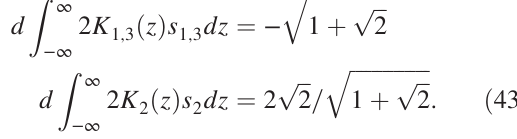
TABLE II. Entrance and exit conditions for the moments in a thin lens approximation with a symmetric triplet and quadrupoles oriented at 45-degree rotations with respect to the longitudinal direction.